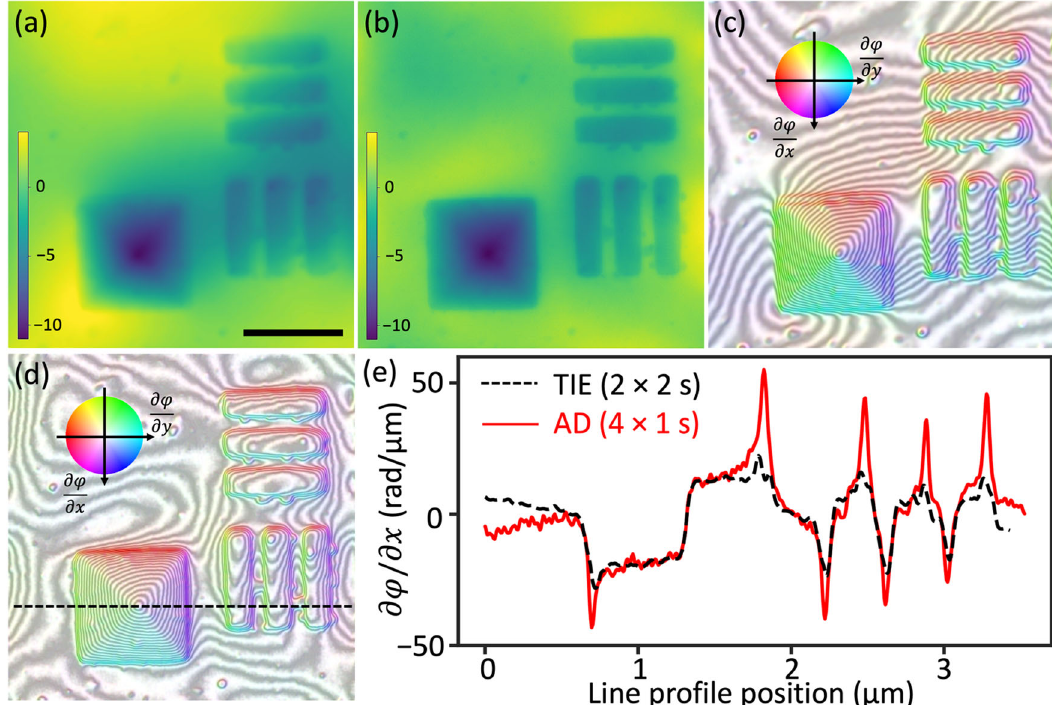
Fig. 5 Application of AD phase retrieval on experimental data. a TIE and b AD retrieved phase. The colorbar applies to both fi gures. The scale bar is 1 μ m. c TIE and ( d ) AD retrieved gradients. TIE phase retrieval was performed on two Fresnel images at Δ f = ± 1.44 mm with 2 s of exposure per image. AD phase retrieval was performed on a mixed focus series of four images at Δ f = ±0.49 mm and ±1 mm with 1 s of exposure per image. The convergence semi-angle was also retrieved in the AD process. e Line pro fi les of the phase gradient. The position at which the line pro fi les were extracted is indicated by the dashed line in ( d